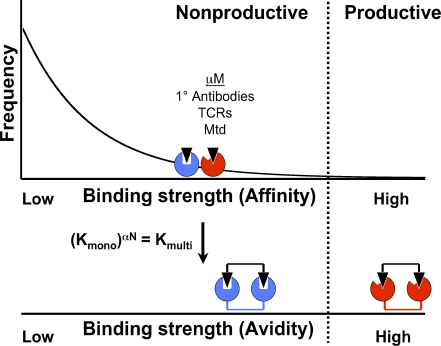
Avidity Provides Amplification and Differential Gain(Top) Distribution of variable proteins and their individual binding strengths (monovalent affinities) to a particular ligand (triangle), with two variants depicted (red and blue). (Bottom) Avidity amplifies monovalent affinities through the exponential factor αN, resulting in some members of the repertoire crossing a threshold required for productive interaction and biological effect. Differences between monovalent affinities are also amplified such that slightly differing monovalent affinities become vastly differing multivalent avidities.